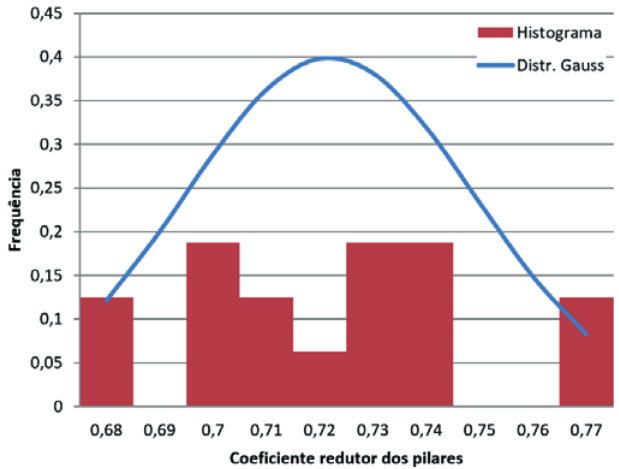
Figura 5 Distribuição de Gauss x Histrograma para a rigidez dos pilares nos exemplos com 3 pavimentos